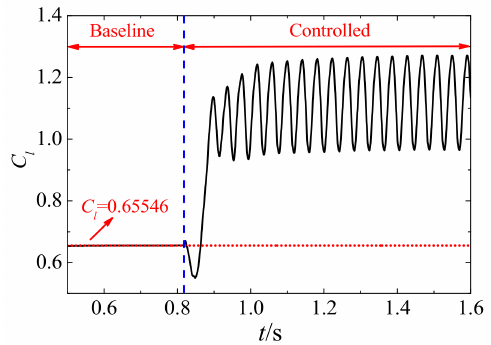
Figure 4. The effectiveness of synthetic jet-based control [28].